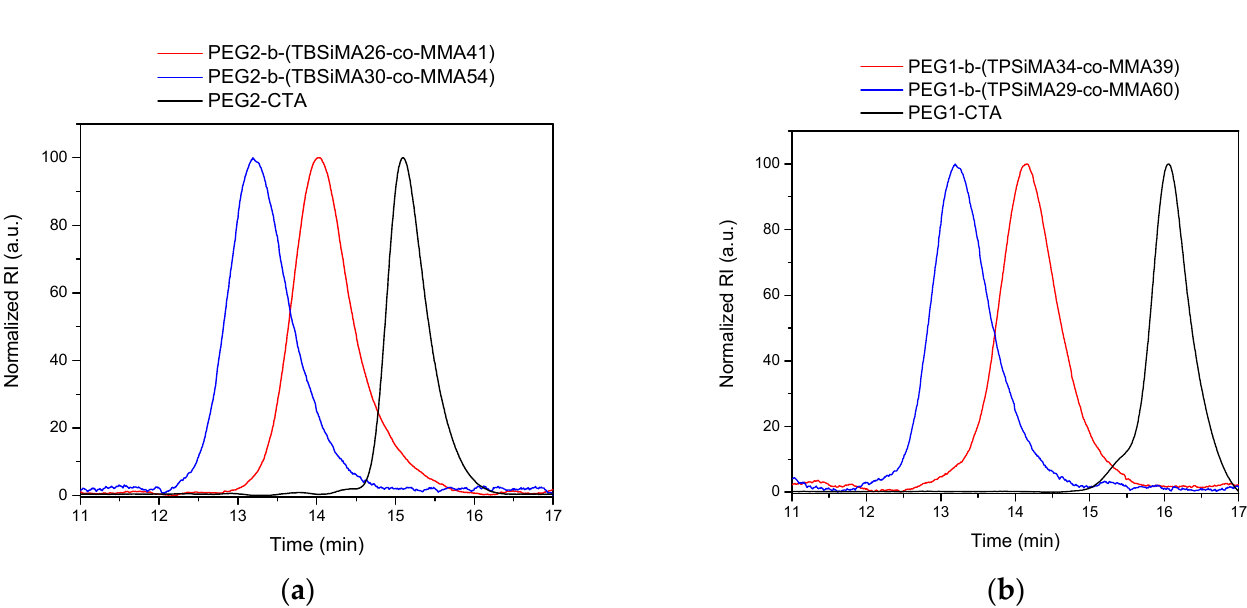
Figure 1. Synthesis of amphiphilic hydrolyzable diblock copolymers via RAFT copolymerization of TRSiMA (R = isopropyl, butyl) and MMA with PEGz-CTA.